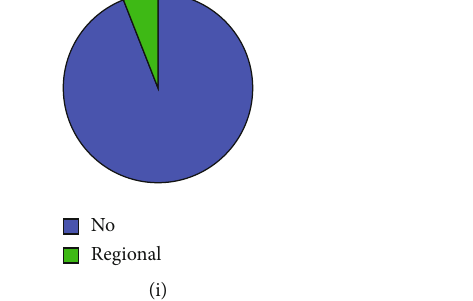
Figure 1: Characteristics of breast lesions found on mammography: (a) patient age (yrs), (b) presence of lesions, (c) shape of the lesions, (d) site of the lesion, (e) location of the lesion, (f) presence of skin thickening, (g) distribution of lesion borders, (h) distribution of breast calci fi cation, and (i) presence of microcalci fi